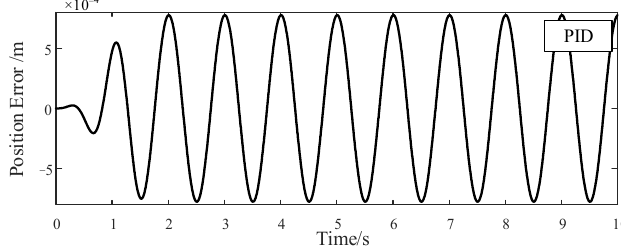
Figure 8. PID Tracking Error of 1 Hz Sinusoidal Signal.